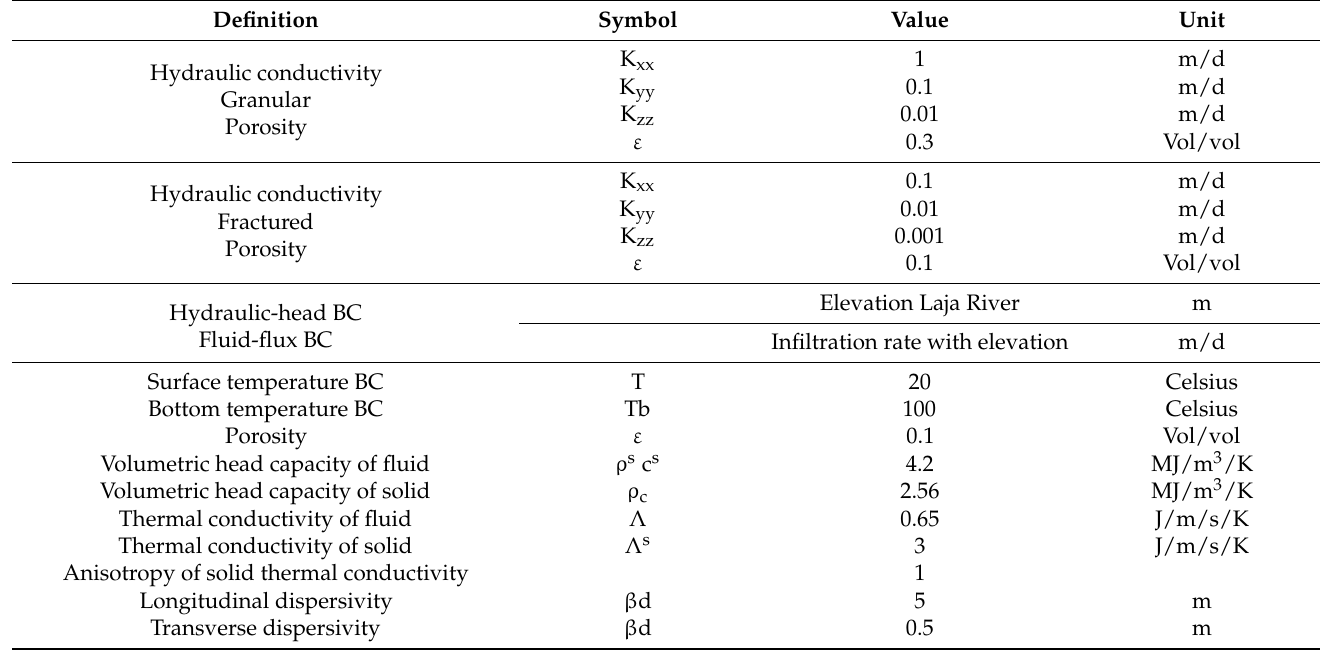
Table 2. Parameters for the flow and heat transport in granular and fractured